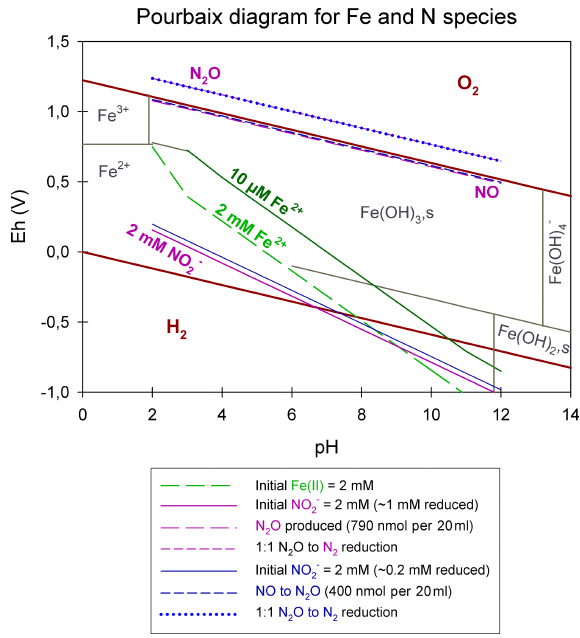
Figure 7. Pourbaix diagram depicting an Fe- and N-species-based system. Overall calculations are based on the Nernst equation using values taken from the literature (for the equation and values see Ta- ble S1). Green lines represent Fe 2 + concentrations; pink lines rep- resent NO − reduction experiments, starting with 2mM NO − , re- 2 2 sulting in the reduction of 1mM NO − , the production of 790nmol 2 per 20mL N 2 O, and a 1 : 1 transformation of N 2 O to N 2 ; and blue lines represent NO − reduction experiments, starting with 2mM 2 NO − , resulting in the reduction of 0.2mM NO − , the production 2 2 of 790nmol per 20mL N 2 O, and a 1 : 1 transformation of N 2 O to N 2 . Reduction and production values were taken from our results presented in Sect.